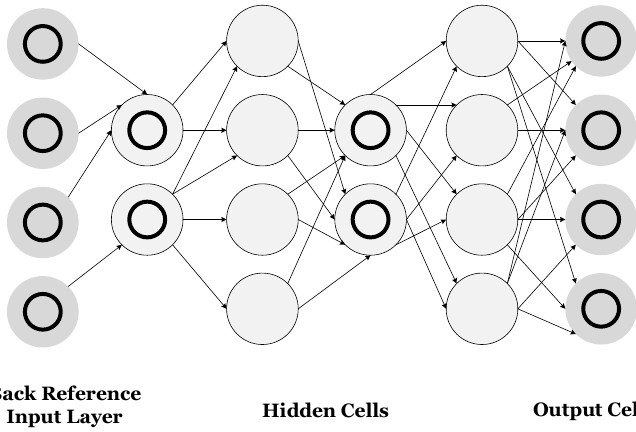
Figure 19. Illustration of deep belief network working.